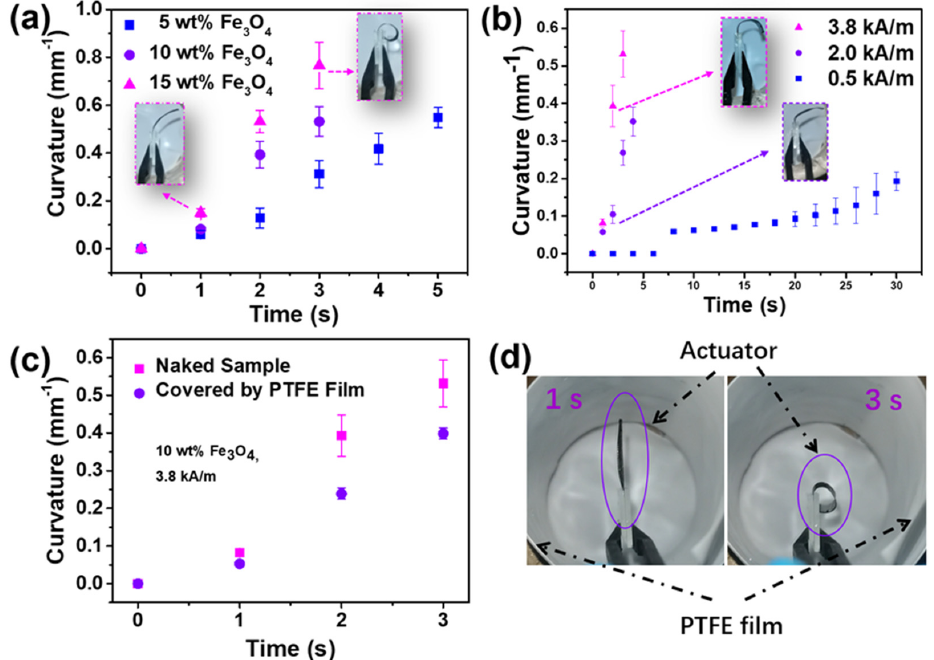
Figure 4. Curvature change profile for different Fe 3 O 4 loading amount actuators upon different magnetic field strength and the penetrable remote − control ability of the actuator. ( a ) the exposure time-dependent curvature of the composite actuator with different Fe 3 O 4 loading amount; ( b ) the exposure time − dependent curvature of the composite actuator with 10 wt% − loaded Fe 3 O 4 particles upon different magnetic field strength; ( c ) the difference of curvature change profile of the naked sample and the one covered by a PTFE film indicating the penetrable remote − control ability, and ( d ) the image of PTFE-film covered sample.